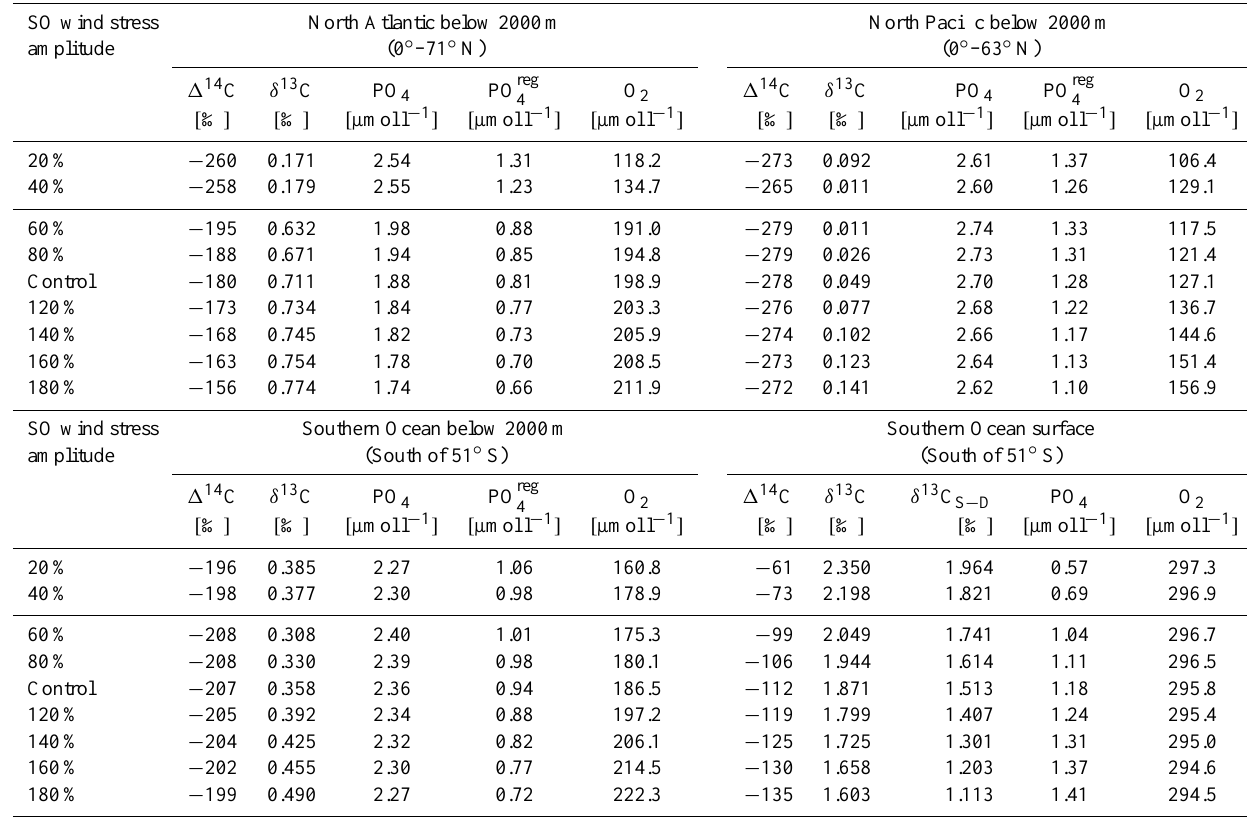
Table 3. Ocean ventilation experiments in the ocean-sediment model: simulated changes in ocean biogeochemistry of different ocean regions at